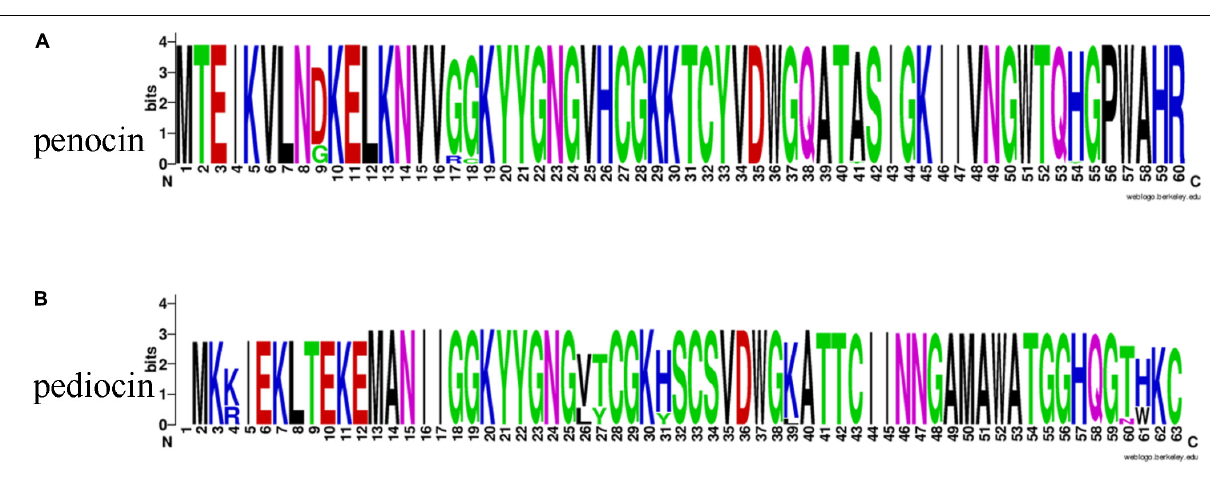
FIGURE 12 | The Weblogo of bacteriocin consensus. (A) The Weblogo of penocin consensus. (B) The Weblogo of pediocin